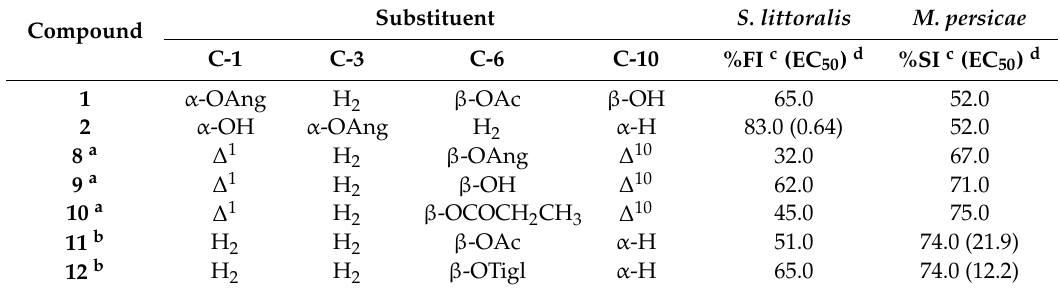
Table 5. Antifeedant structure-activity relationships of Senecio furanoeremophilanes against S. littoralis and M. persicae